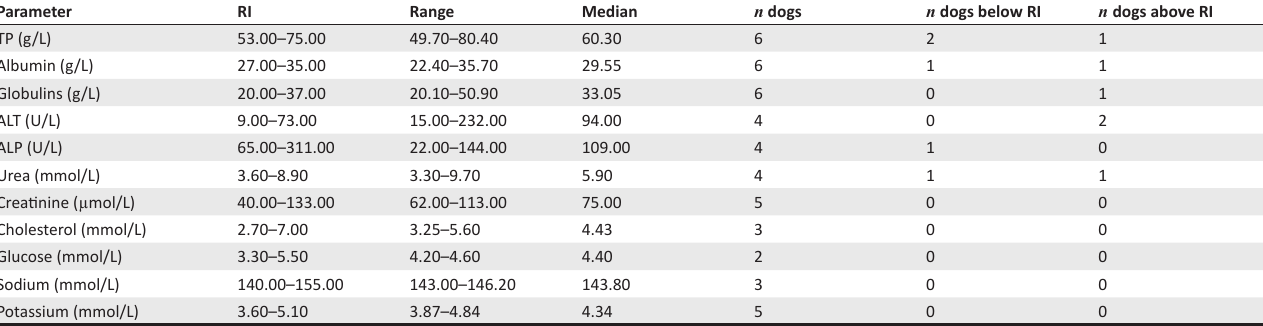
TABLE 3: Description of the biochemistry profile at admission of dogs diagnosed with canine theileriosis.